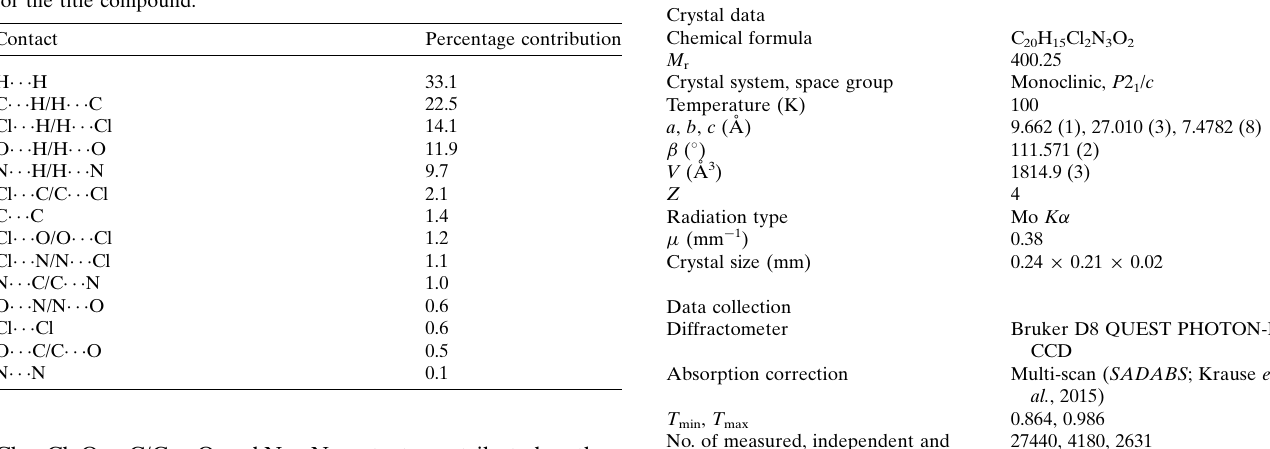
Table 3 Percentage contributions of interatomic contacts to the Hirshfeld surface for the title